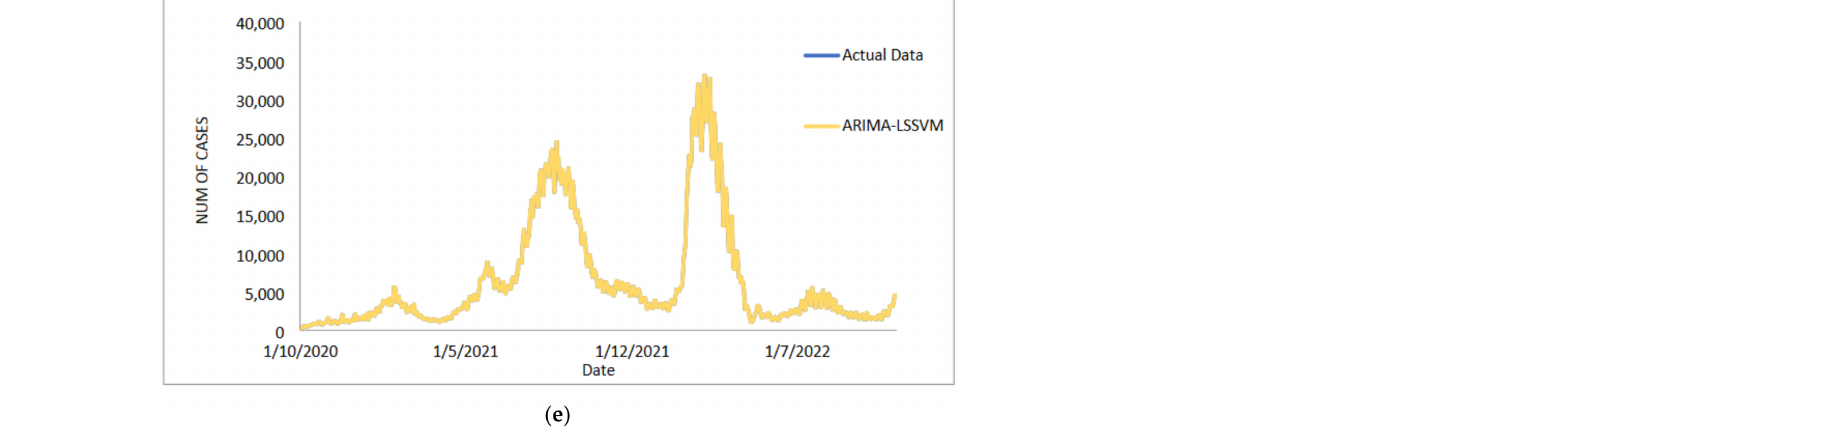
Figure 3. Results obtained from the proposed model for daily new positive COVID-19 cases dataset: ( a ) actual data vs. ARIMA model, ( b ) actual data vs. LSSVM models, ( c ) actual data vs. SVM model, ( d ) actual data vs. ARIMA–SVM models, ( e ) actual data vs. ARIMA–LSSVM models.